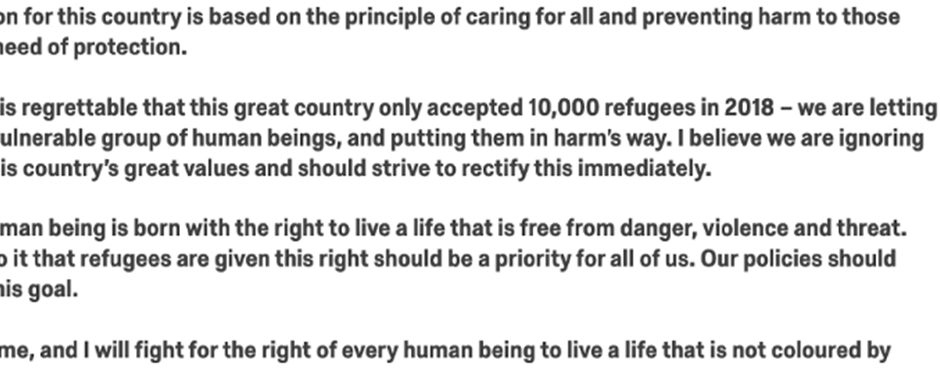
Figure 2. Morally framed political speech excerpt (care).